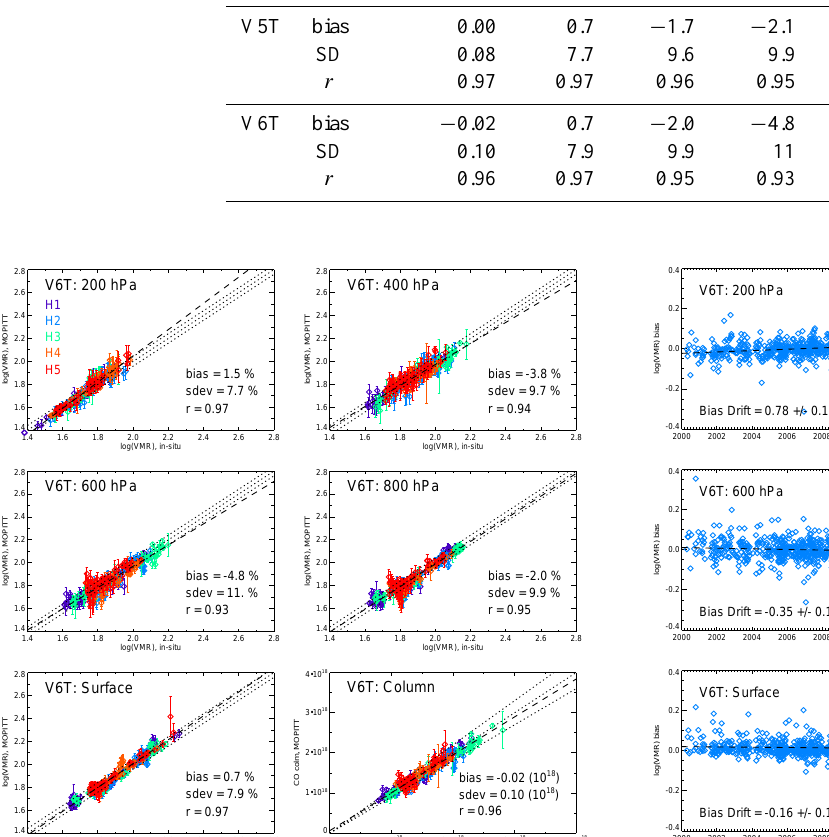
Table 3. Summarized validation results for V5T and V6T products based on in situ data from HIPPO field campaign. See caption to Table 2. Total column Surface